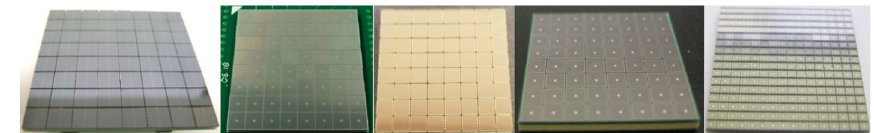
Fig. 8 SiPM arrays with different pixel sizes. (from left to right) 8 8 8 array of 4 × 2 2 mm 2 SiPMs from Hamamatsu, and 16 ×